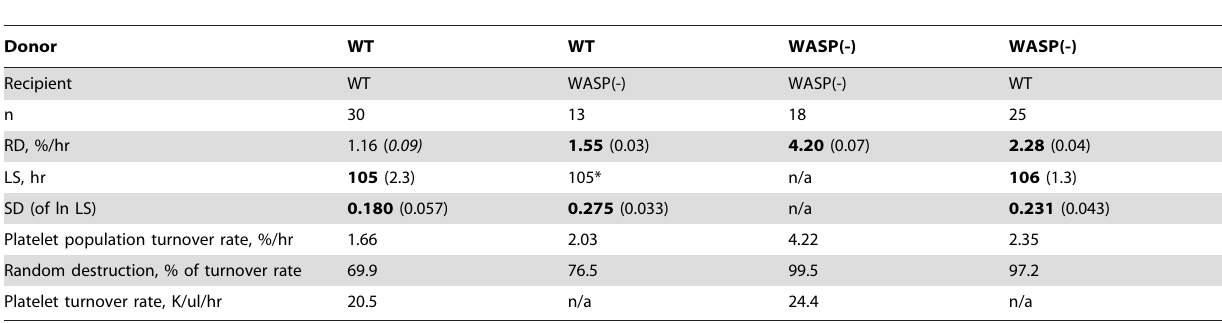
Table 1. Optimal platelet consumption parameters and associated